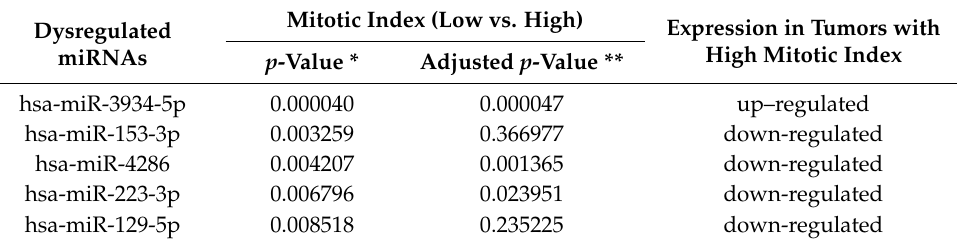
Table 3. Significantly differentially expressed miRNAs between low (0–1) and high ( ≥ 2) mitotic index in rectal neuroendocrine